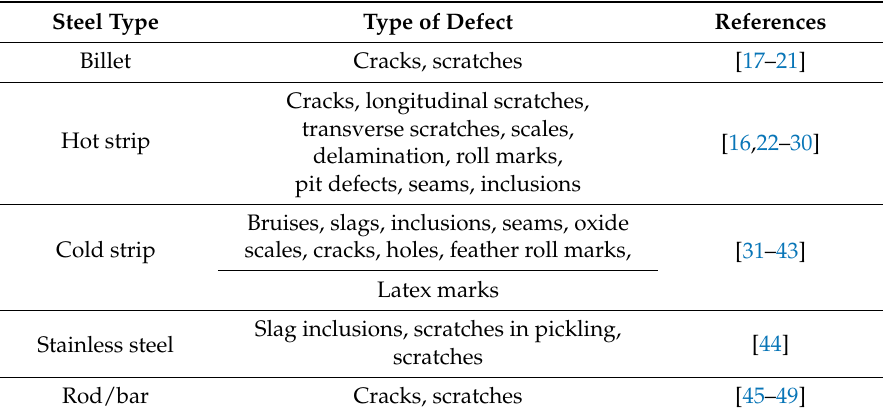
Table 1. Common defect types of different steel